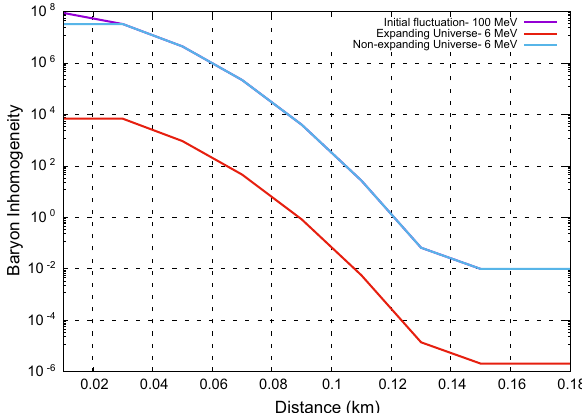
Fig. 8 Thedecayoftheinitialfluctuationisshowninlogscalebetween 100 and 1